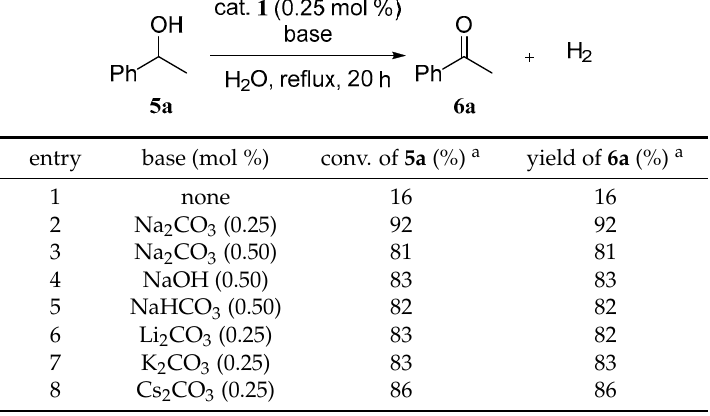
Table 2. Optimization of the basic additive for the dehydrogenative oxidation of 5a to 6a catalyzed by 1 in aqueous media.